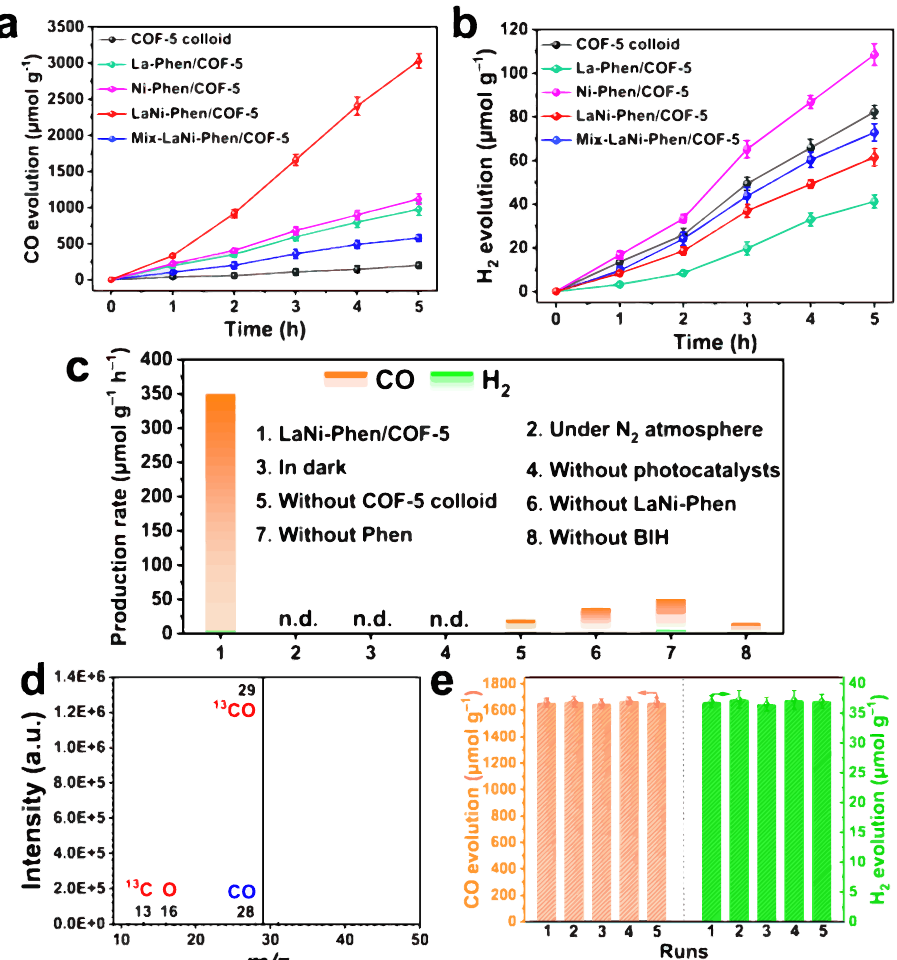
Fig. 4 | Photocatalytic CO 2 reduction performance. a , b Time-dependent CO ( a ) and H 2 ( b ) evolution curves under UV-vis light irradiation ( λ >380nm) within 5h usingCOF-5colloid(blackspheres),La-Phen/COF-5(greenspheres),Ni-Phen/COF-5 (pink spheres), LaNi-Phen/COF-5 (red spheres), and mix-LaNi-Phen/COF-5 (blue spheres). c Control experiments of the photocatalytic CO 2 reduction performance